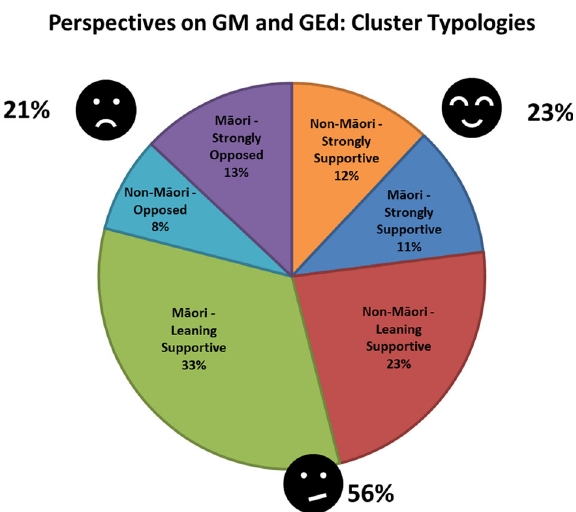
Fig. 1 Typologies of survey participants ’ perspectives on GM and GEd. Six typologies emerged through K-Means cluster analysis that reveal that both M ā ori and non-M ā ori have multiple perspectives about GM and GEd, ranging from strongly supportive to Leaning Supportive to Opposed. Non- M ā ori Strongly Supportive areshown in orange, M ā ori Strongly Supportive dark blue, non-M ā ori Leaning Supportive red, M ā ori Leaning Supportive green, non-M ā ori Opposed light blue, and M ā ori Strongly Opposed purple.